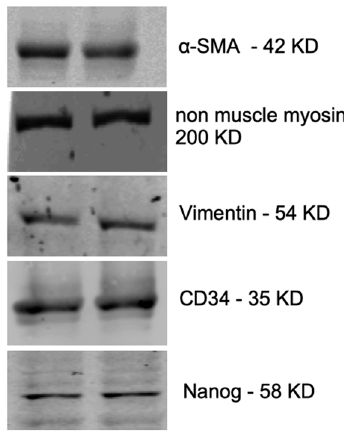
Figure 4. Western blot images of several markers in the fetal VSCs. The two representative bands are from the VSCs from two di ff erent ovine fetuses.